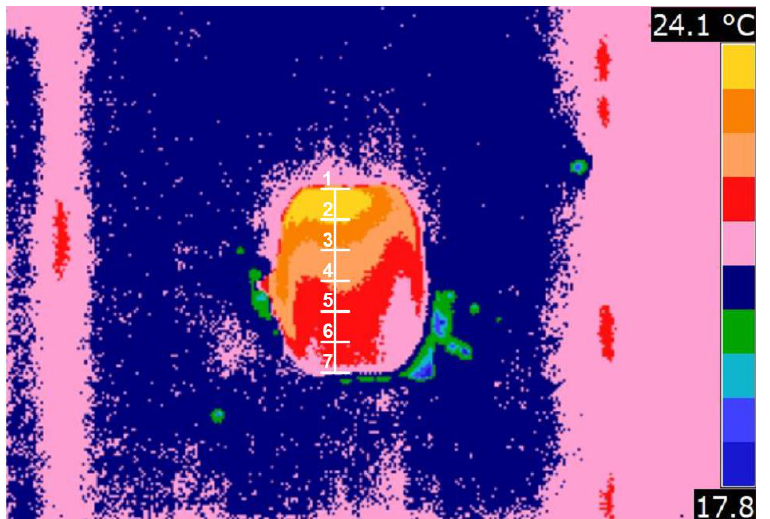
Figure 8. Thermogram processed in FLIR Quick Report with measuring points where temperature readings were taken to prepare the temperature distribution on the briquette surfaces: Point 1—end of briquette consolidation; Point 7—start of briquette consolidation.